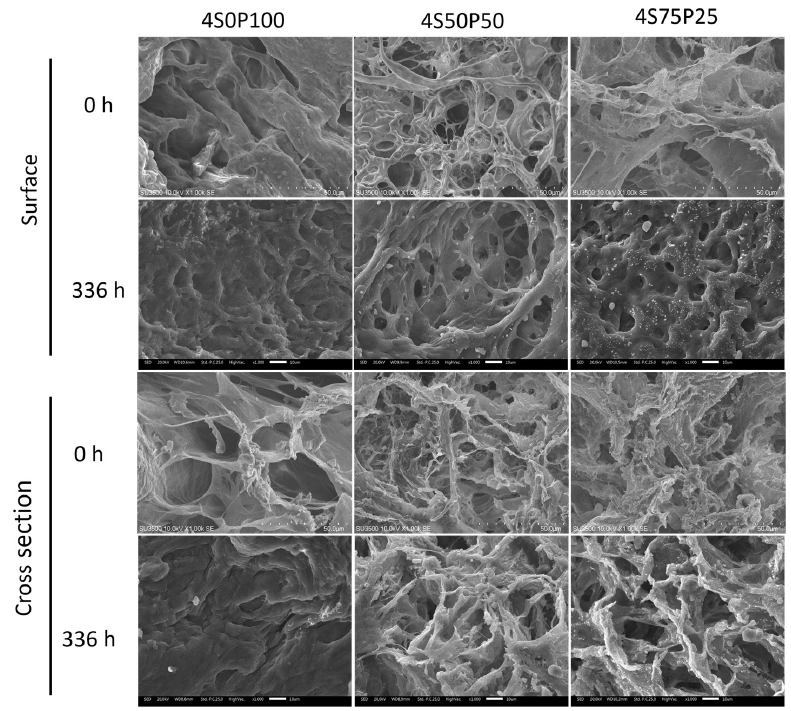
Figure 7. Surface ( top ) and cross-section ( bottom ) morphology of 4% PVA-sericin hydrogel before PBS solution immersion and after 336 h (14 days) PBS solution immersion.